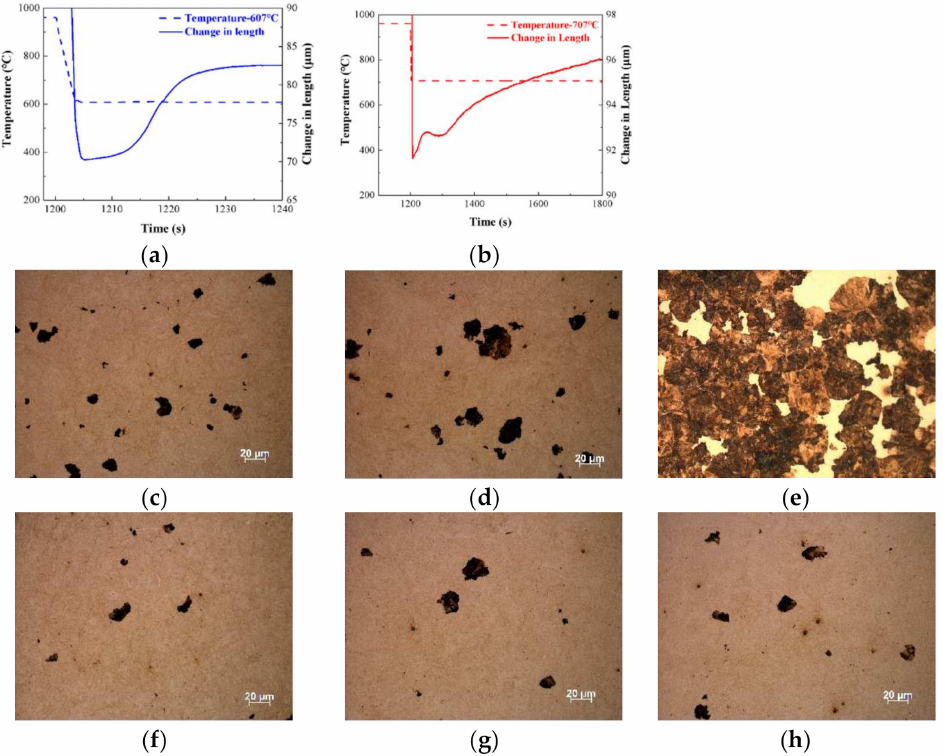
Figure 1. Dilatometer curves of isothermal transformation at 607 ◦ C ( a ) and 707 ◦ C ( b ); OM diagram of short-time isothermal quenching structure. ( c ) 607 ◦ C—5 s; ( d ) 607 ◦ C—10 s; ( e ) 607 ◦ C—15 s; ( f ) 707 ◦ C—5 s; ( g ) 707 ◦ C—10 s; ( h ) 707 ◦ C—15